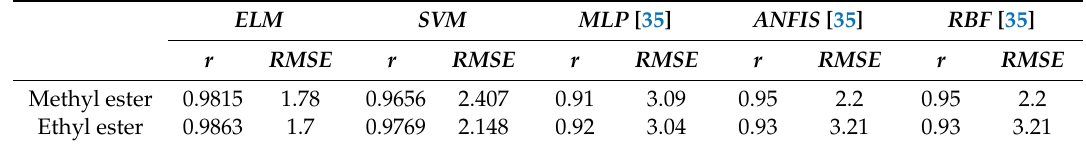
Table 5. The results of the training stage for both ELM and SVM methodologies.